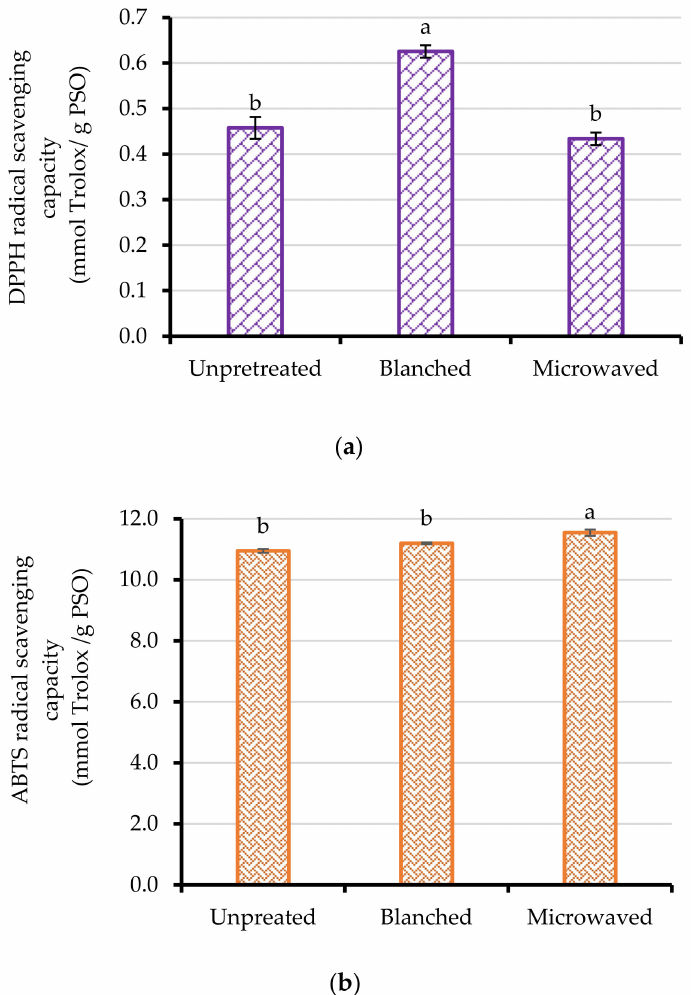
Figure 3. ( a ) DPPH and ( b ) ABTS radical scavenging capacity of cold-pressed pomegranate seed oil (PSO) from unpretreated, blanched (95 ± 2 ◦ C/3 min), and microwave-heated (261 W for 102 s) seeds. Columns followed by different letters are significantly different ( p < 0.05) according to Duncan’s multiple range test. Vertical bars indicate the standard deviation of the